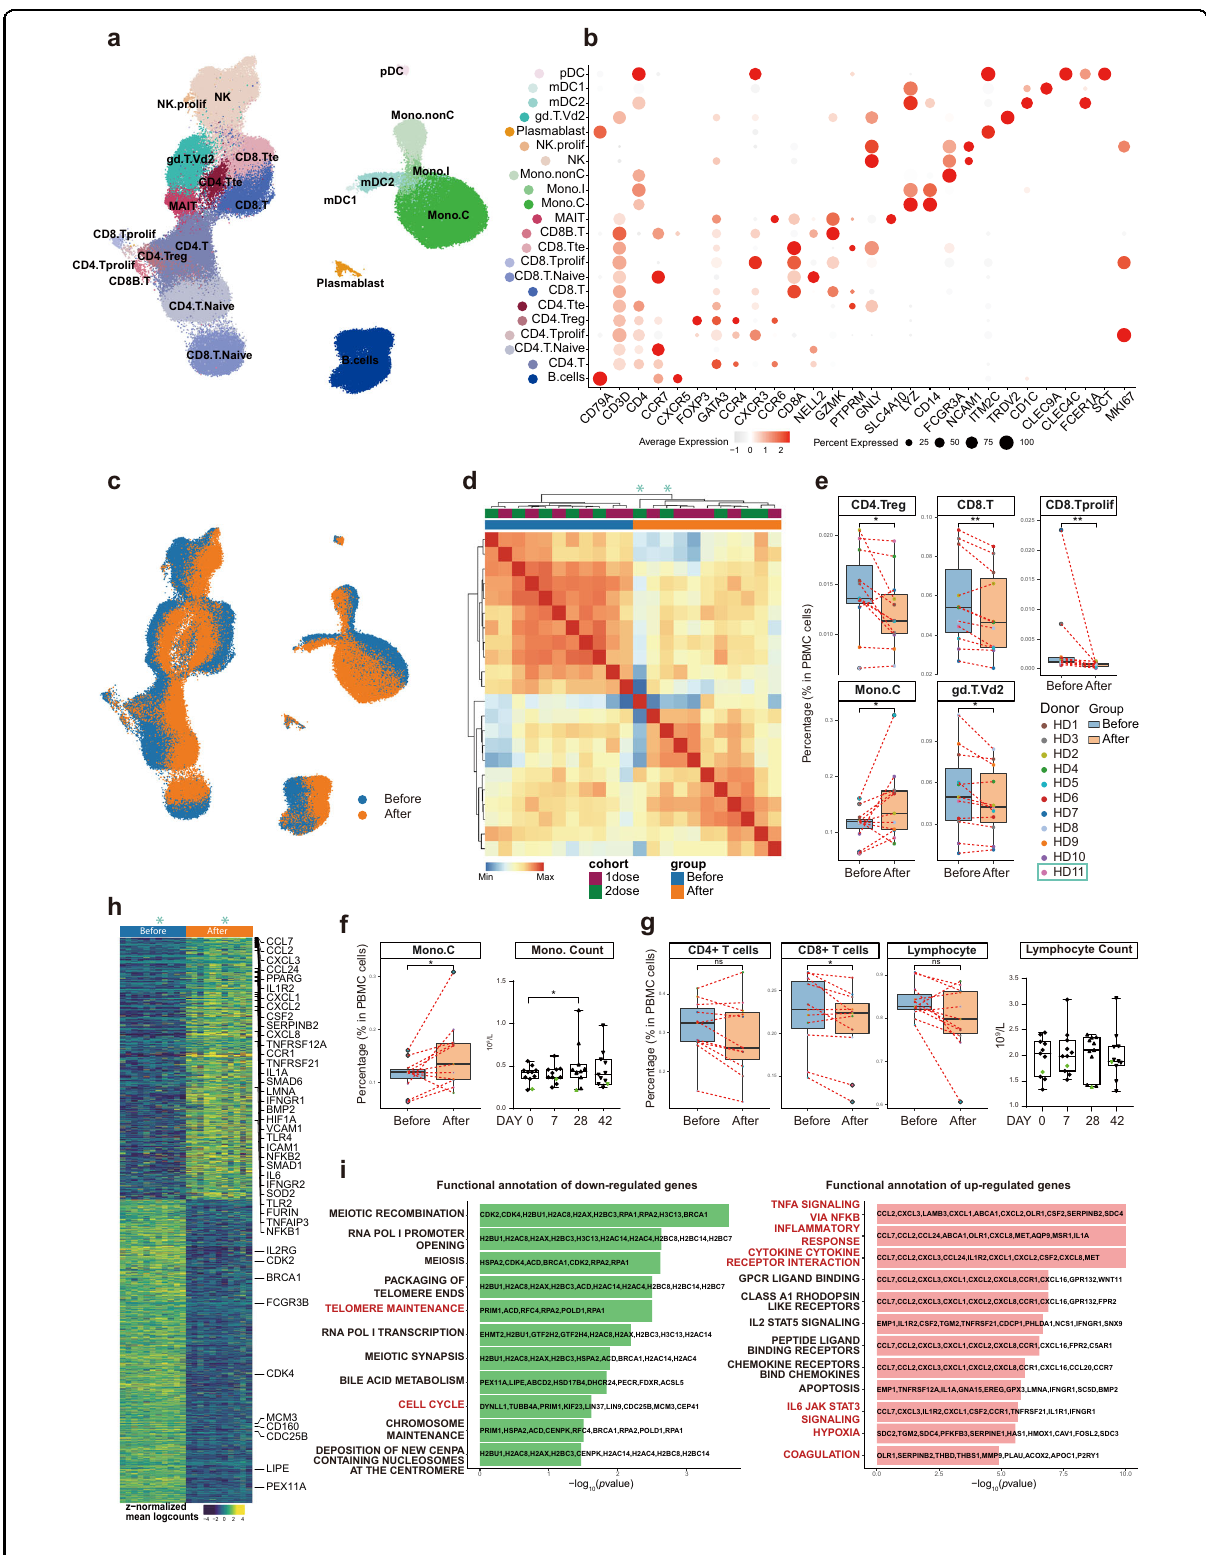
Fig. 3 (See legend on next